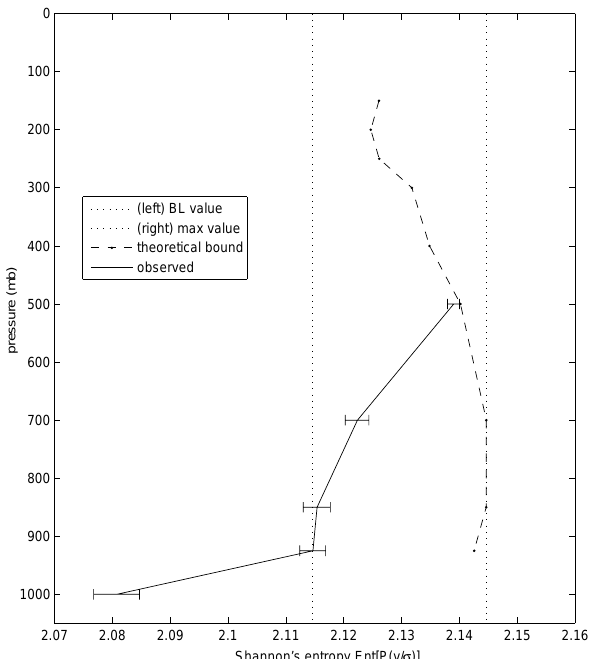
Fig. 5. Shannon’s entropy for the Weibull’s distributions fitted to the radiosonde wind speed data from MP at 500mb and below (solid line). The wind speed was first normalized by its rms value. The maximal Shannon’s entropy and the value associated with k = 5 / 3 (dotted lines) are shown. The theoretical bound (dashed line) for reduction from maximal Shannon’s entropy is computed for wind anomaly using Eq. (8).